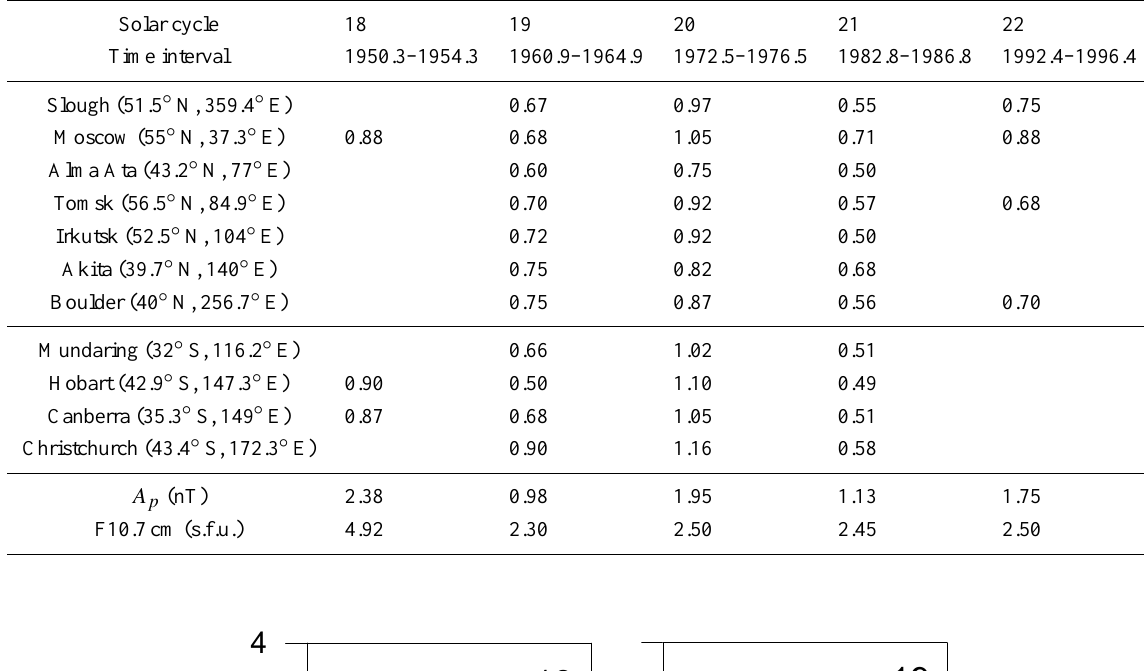
Table 1. Period-averaged amplitudes from 25- to 31-day periods of fo F2 (all the hourly data, 0.1MHz) over 4-year intervals before sunspot minima. Note that time intervals are in a fraction of years. The last two rows show the period-averaged amplitudes for daily A p and F10.7cm, respectively.